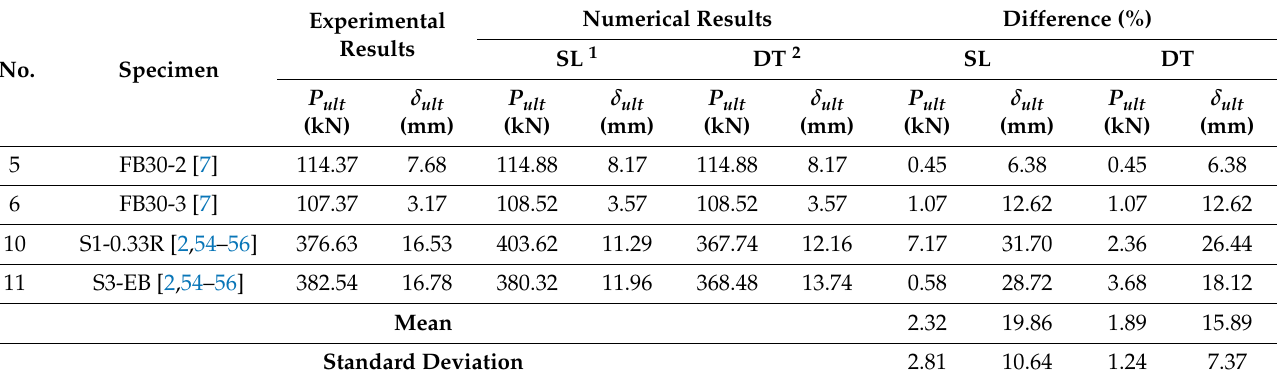
1 Smeared layer element; 2 discrete truss